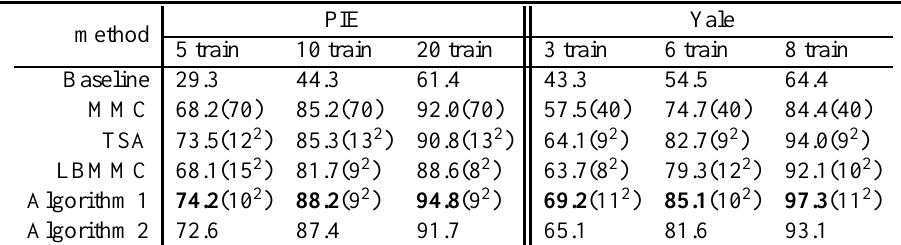
Figure 5: Average recognition rate vs. feature dimensionality( d d for TSA, LBMMC and Algorithm 1, 10 × for MMC is shown). (a,b,c) results on PIE database; (d,e,f) results on Yale database Table 1: Top average recognition rate(dimensionality) of different methods(%) PIE Yale